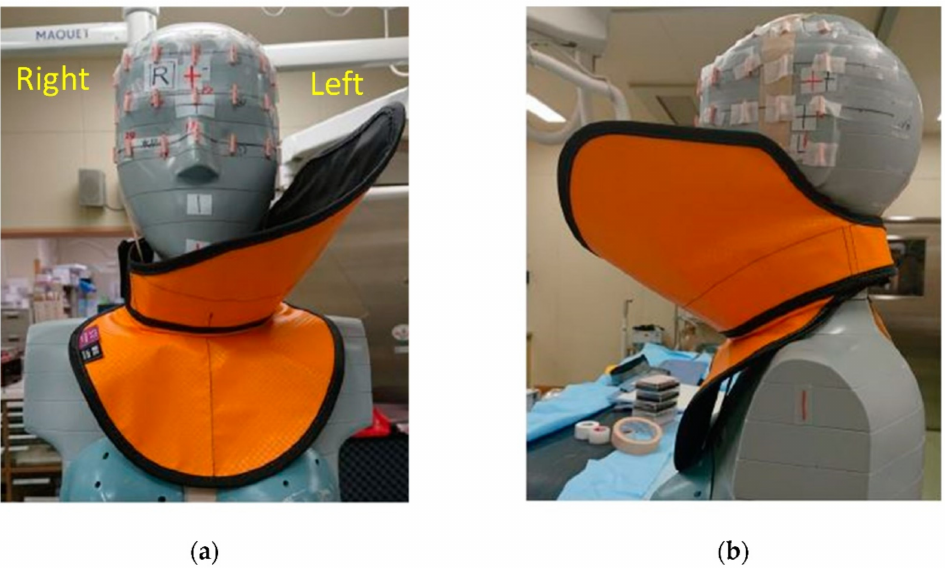
Figure 1. Photograph of the novel shield: ( a ) frontal view; ( b ) lateral view. The neck guard and face shield are fastened together to create a single device, which cannot be disassembled. The face shield is attached to the left side of the neck guard and protects the left side of the physicians’ neck and face from radiation. The novel shield was designed so that it does not obstruct IVR physicians’ field of